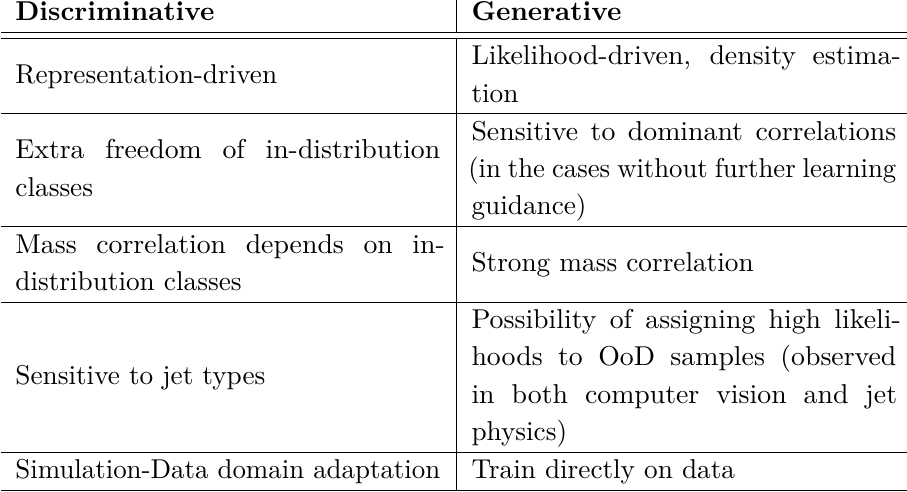
Table 4 . Comparison between the discriminative and the generative approach in generic anomalous jet